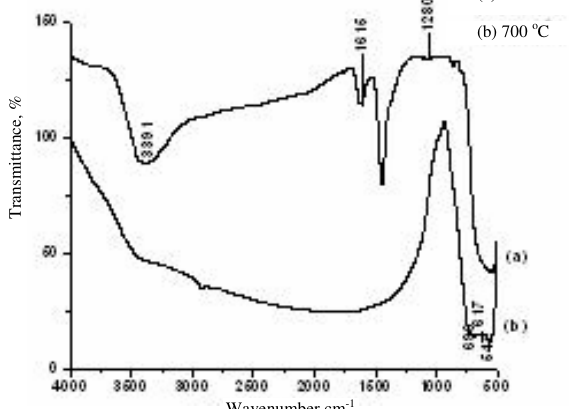
Figure 4. (a-b) FT-IR spectra of as-synthesized NiTiO